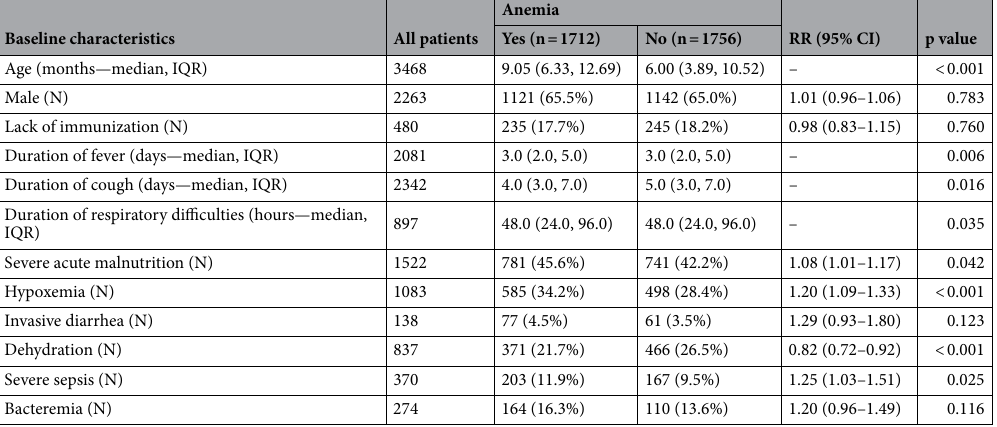
Table 1. Baseline characteristics of under-five children with anemia hospitalized for pneumonia/severe pneumonia. N total number of participants, RR relative risk, CI confidence interval, IQR inter-quartile range, ()